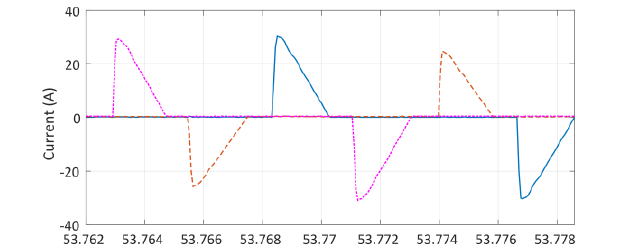
Fig. 8. Waveform in 𝑀 1 with 𝑇𝐻𝐷 𝑖 - 𝑁 𝐿 connected. Table XI. Values in 𝑀 1 with 𝑇𝐻𝐷 𝑖 - 𝑁 𝐿 connected.